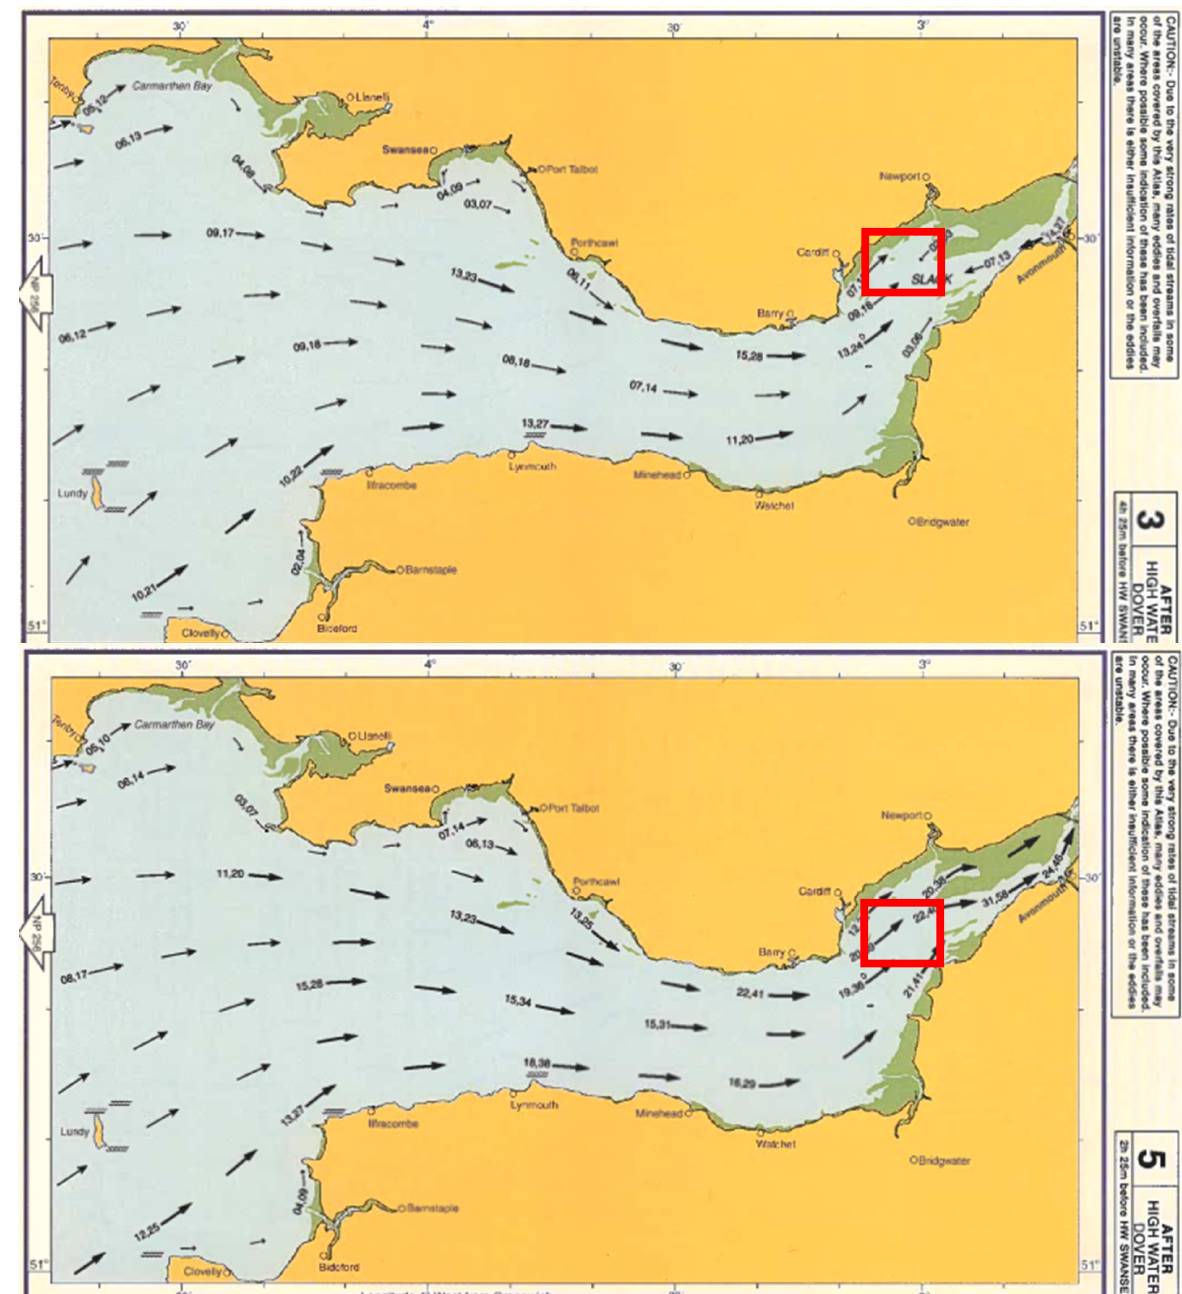
Figure 3. Tidal atlas data for Bristol [39].